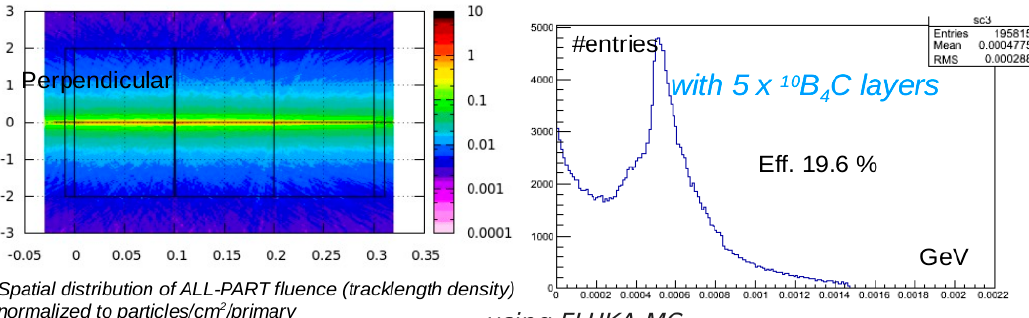
Figure 2 . Thermal neutron detection efficiencies of a two-mesh detector unit (five layers of 10 B 4 C with a thickness of 1.5 μ m each) [18].